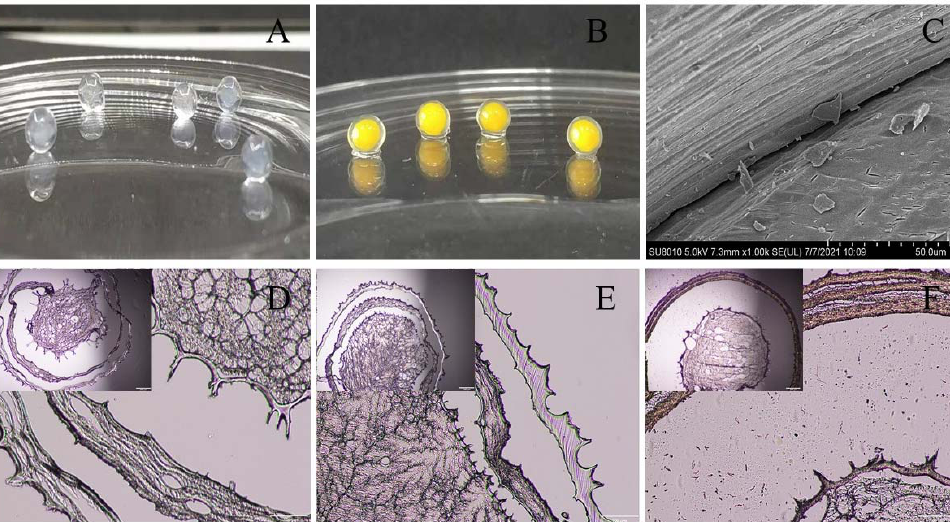
Figure 5. The digital photographs and microstructures of the gel microspheres. ( A ) Blank gel microspheres; ( B ) VB and BC-loaded-gel microspheres; ( C ) SEM photographs of cross sections of the microspheres; ( D ) Microscopic image of 0.5% SA three-layer-gel microspheres; ( E ) Microscopic image of 1.5% SA three-layer-gel microspheres; ( F ) Microscopic image of 2.5% SA three-layer-gel microspheres copy after sectioning the samples using a microtome.